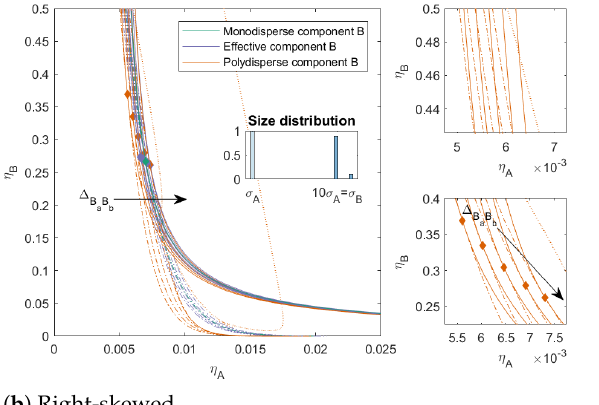
Figure 6. Phase diagram for binary (component A and B ) nonadditive hard sphere mixture with size ratio q = σ A / σ B = 1/10 versus the partial packing fractions, η A and η B ; component A is monodisperse, component B is polydisperse ( PD = 4.80), . The symbols σ A and σ B refer to the diameters of the species A and B, respectively. The interaction between components A and B is additive, the interaction between the subcomponents B nonadditive, the nonadditivity parameter ∆ − 0.1 to 0.1 with a step size of 0.05 (the arrow indicates increasing ∆ B a B b was varied from The spinodal (solid line) and binodal (dashed line) meet each other at the plait point (diamond), the three-phase boundary is indicated with a dotted line. The smaller right-hand figures represent zoomed in versions of the left larger